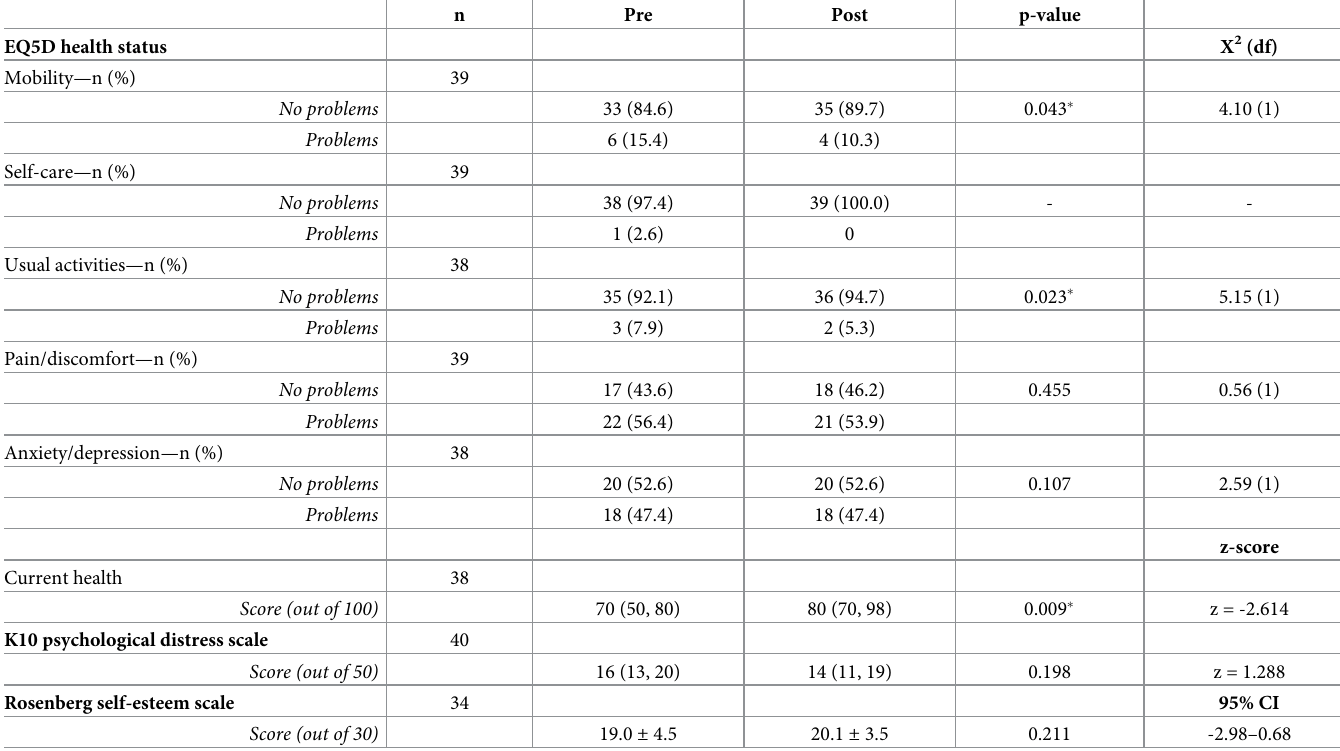
in body pains; improved BP; being sick less often; fewer sugar cravings; and improved skin health. Table 8. Pre- and post-programme measures for self-reported health status, psychological distress and self-esteem (participants with pre- and post-programme data) � . n Pre Post